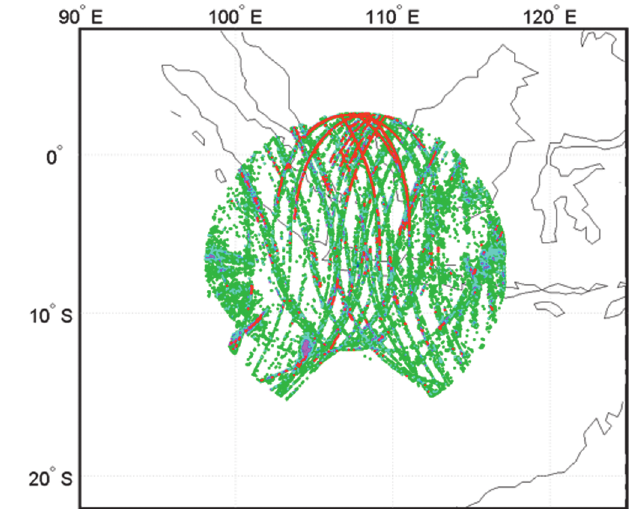
Fig. 3. Geographic distribution of S 4 at different levels measured at all satellites received in Bandung in 2006. All S 4 - indices measured with all GPS - satellites which are greater than 0.2 (green), greater than 0.3 (cyan), greater than 0.4 (magenta), greater than 0.5 (red) of the year 2006 are plotted at their corresponding sub-ionos- pheric